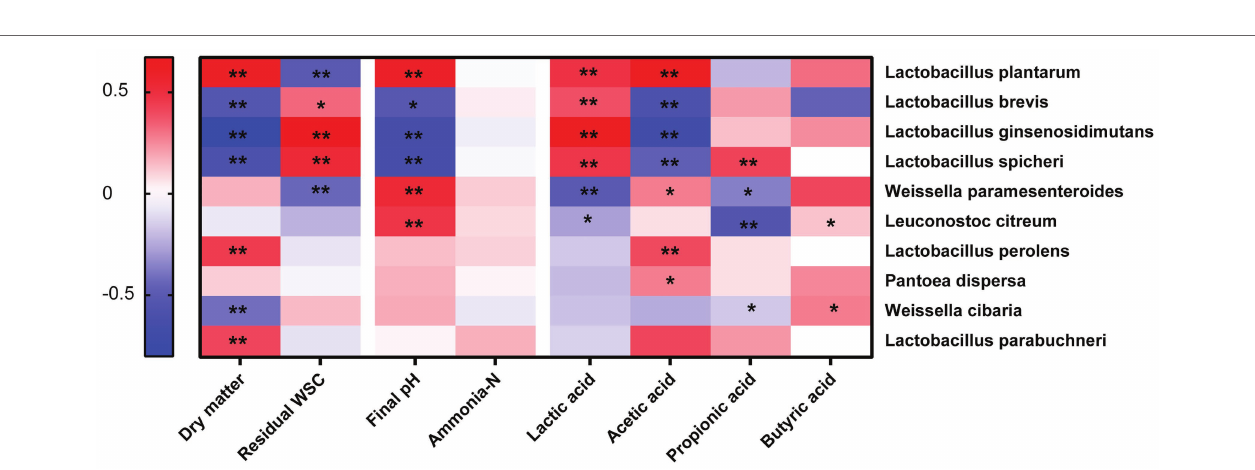
FIGURE 4 | Spearman analysis between silage parameters and bacterial species. *significance at p < 0.05; **significance at p <